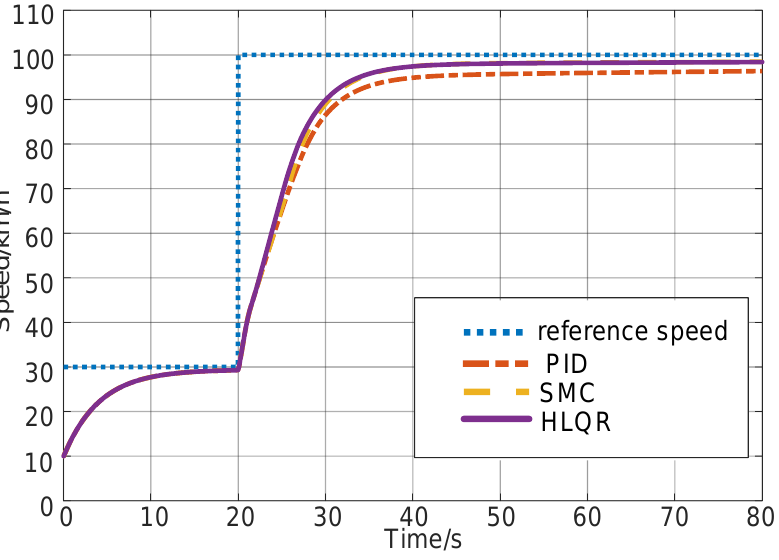
Figure 10. Vehicle speed on the split road surface controlled by PID/SMC and HLQR. The torque of the left wheel for axle 1 (1 L), axle 3 (3 L), and axle 6 (6 L) is shown in Figure